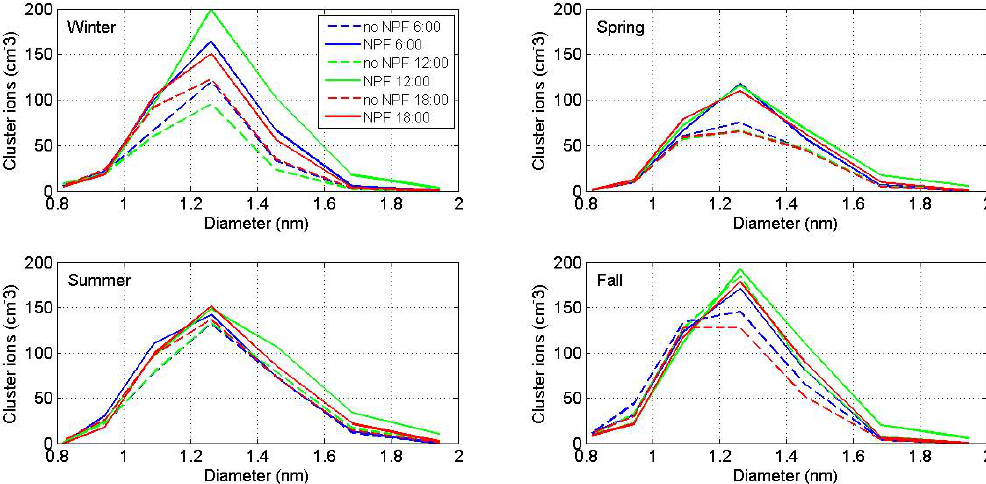
Fig. 8. Positive cluster ion mode size distribution. Blue, green and red curves correspond to 06:00, 12:00 and 18:00UTC hourly median concentration, respectively. Continuous lines are used for event days and dashed lines for non-event days. February 2007–February 2012, Puy de